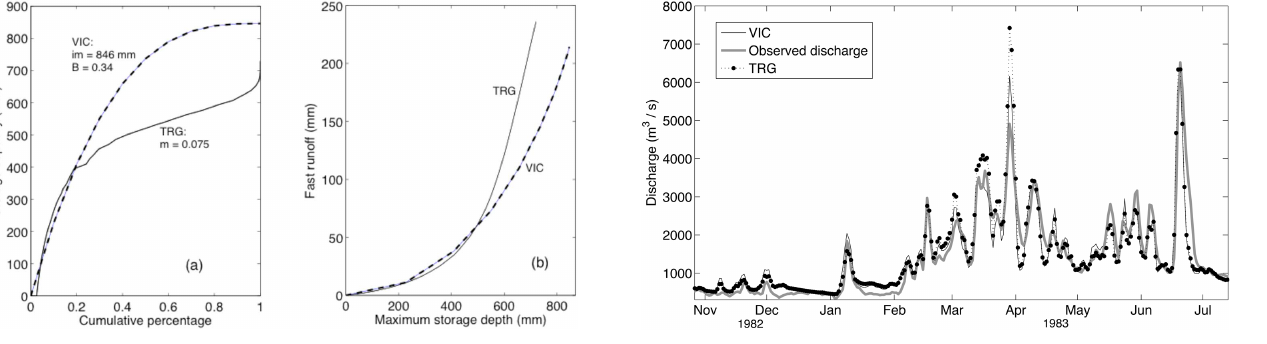
Fig. 12. Observed and simulated discharge for Dongjiang river basin both TRG storage distribution and fitting VIC infiltration curve shown in Fig.